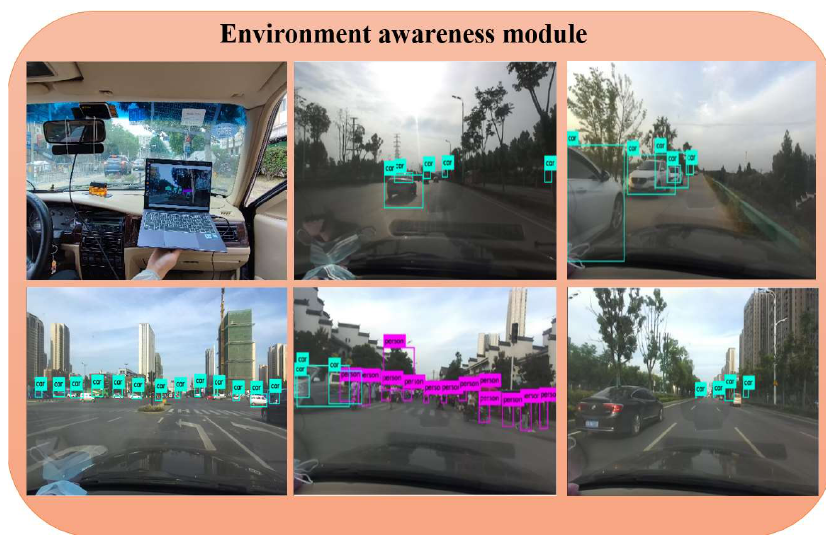
Figure 12. Schematic diagram of real-time detection results.